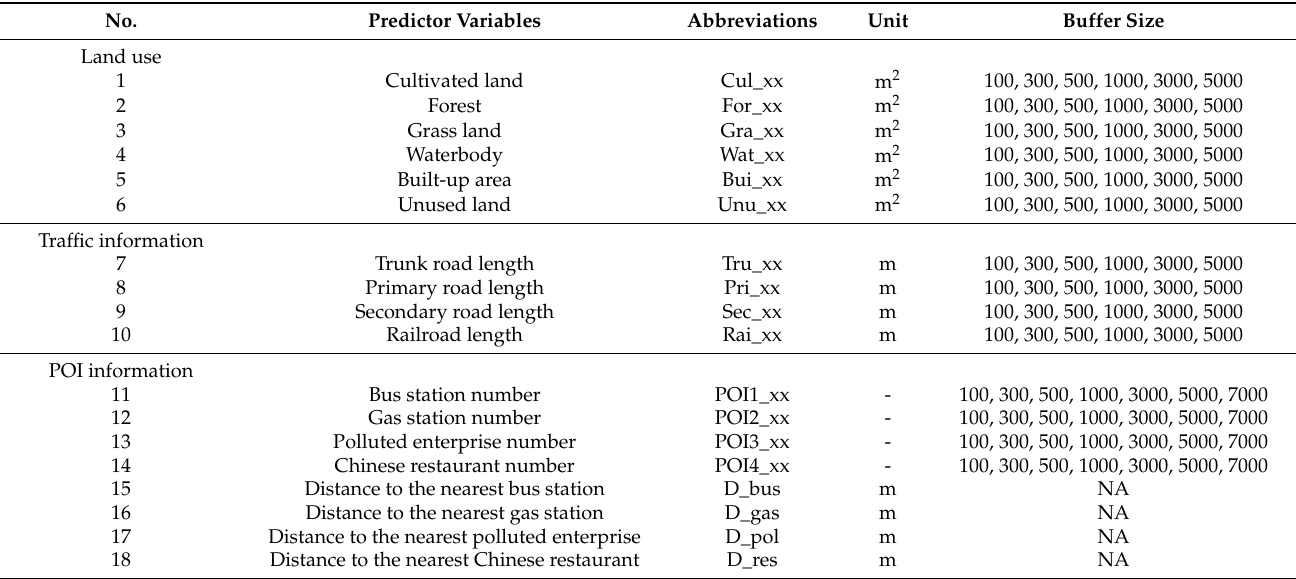
Table 1. Description of the vector predictor variables in the LUR models of